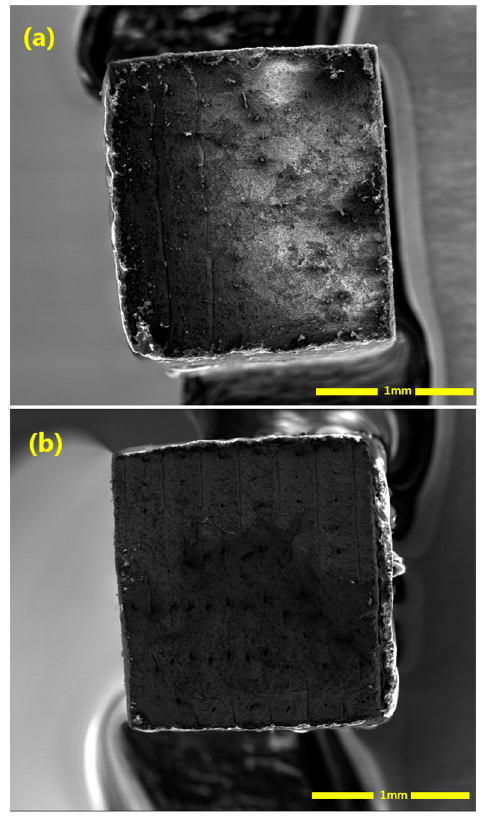
Figure 10. SEM image showing the fracture surfaces of the specimens. ( a ) Fracture surface of the vertically-printed specimen; ( b ) fracture surface of the horizontally-printed specimen.